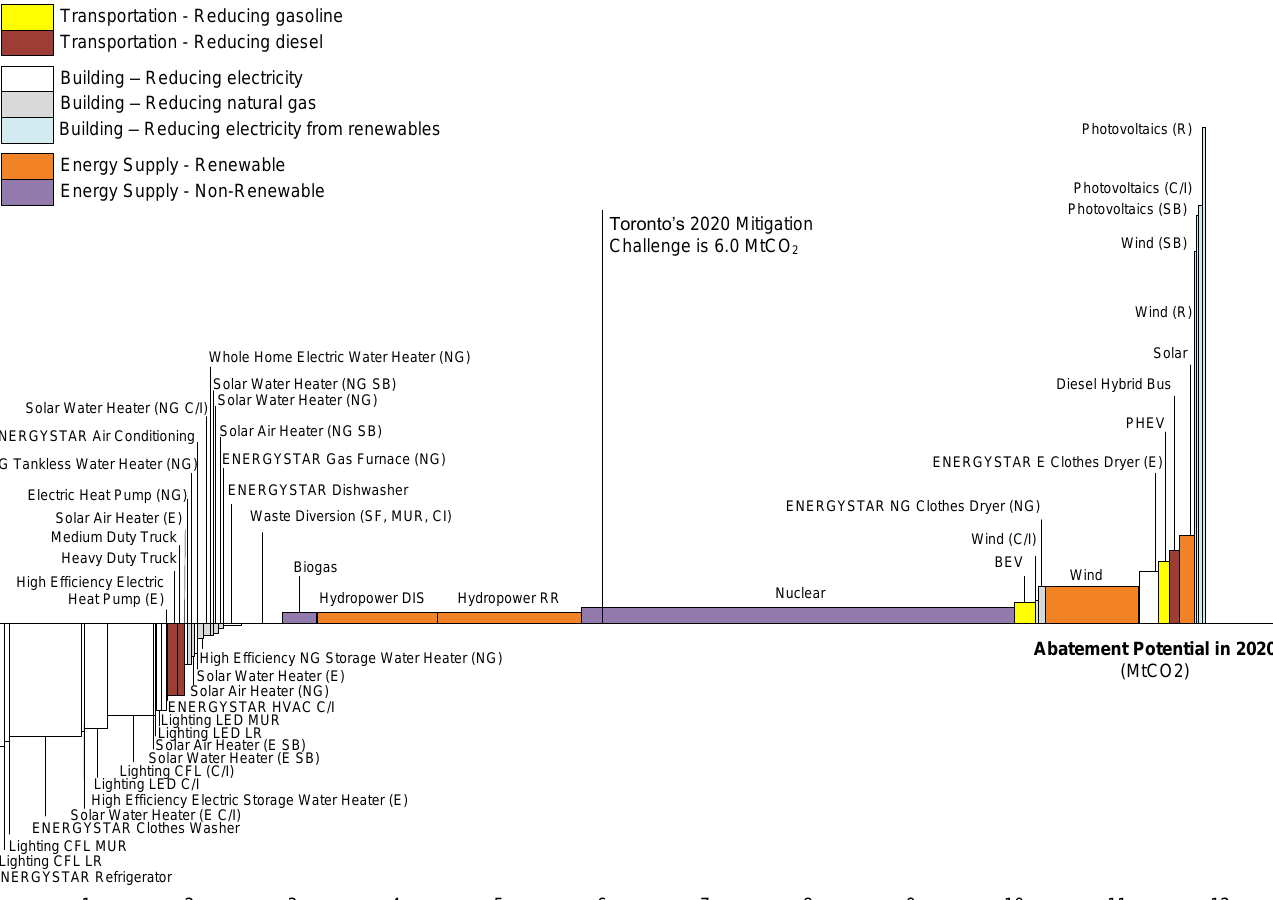
Figure 1. Toronto 2020 marginal abatement cost (MAC) curve showing mitigation measures by sector and a marginal abatement cost of 70 $/tCO 2 for the city’s 2020 target (R = Residential, LR = Low-rise, MUR = Multi-unit residential, SF = Single-family, SB = Small Business, C/I = Commercial/Institutional, NG = Natural gas, E = Electricity).